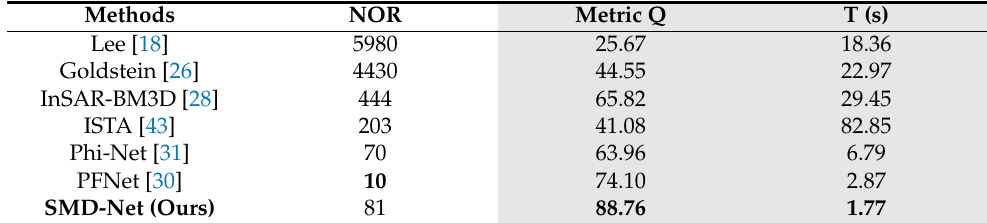
Table 3. The metrics of the seven methods on the measured interferogram of area B. Metric Q is the core accuracy index. T is the speed index.